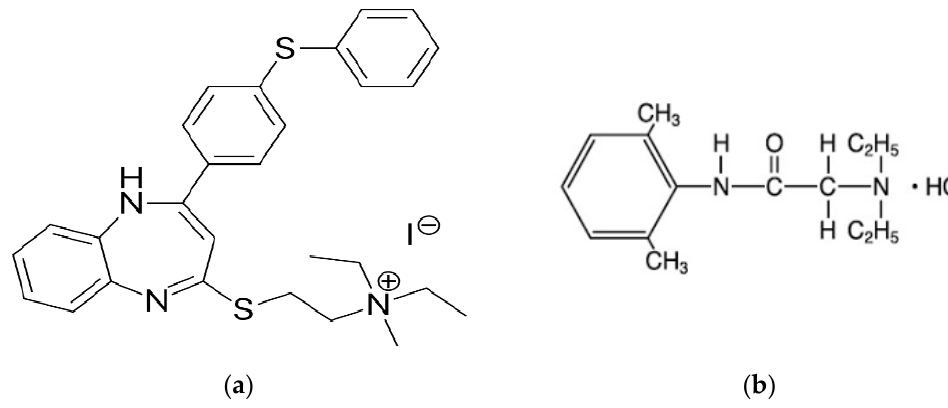
Figure 1. Chemical structures of ( a ) tibezonium iodide and ( b ) lignocaine